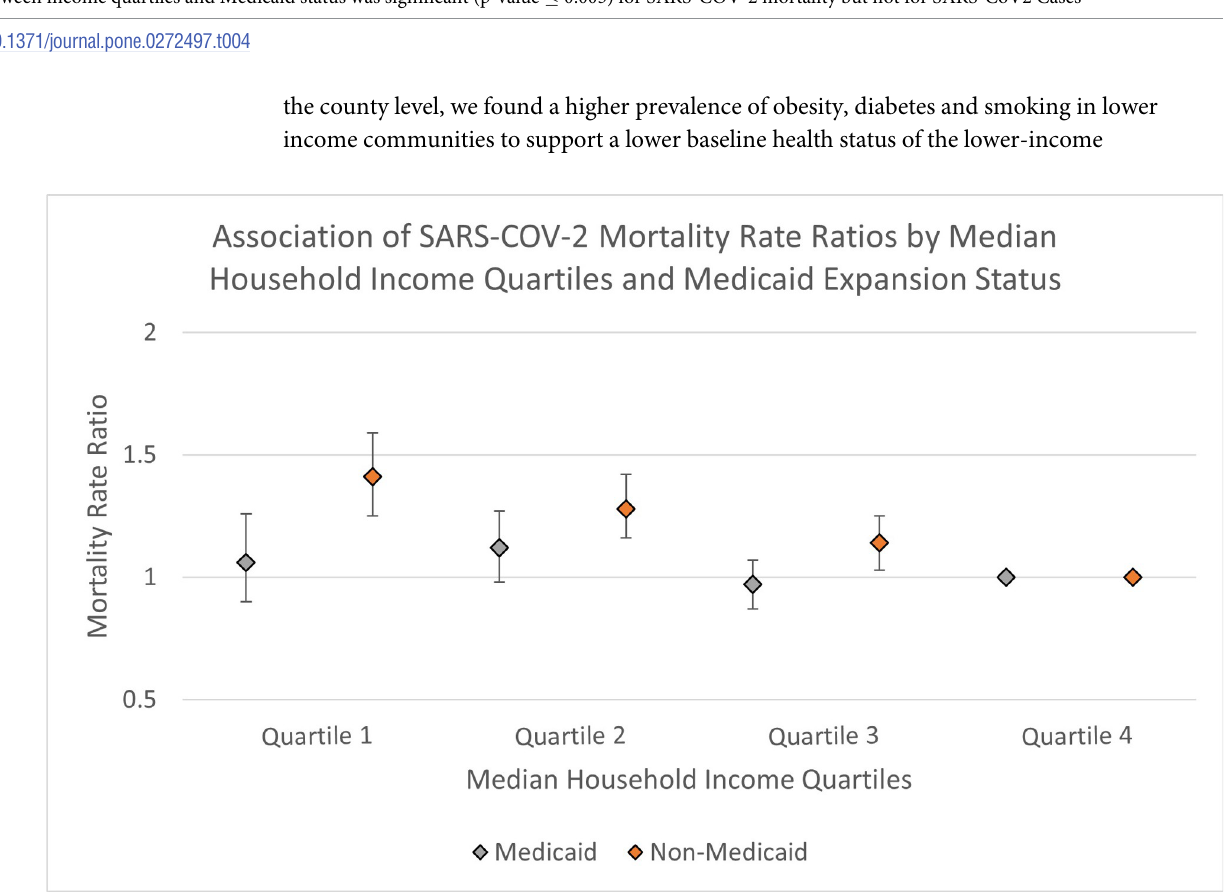
Fig 1. Association of SARS-COV-2 mortality rate ratios (95% confidence intervals) by median household income quartiles, for counties in Medicaid (gray diamond) and non-Medicaid expansion states (orange diamond), referent = Quartile 4. In fully adjusted analyses, median household income quartiles were associated with COVID-19 mortality only in counties within non-Medicaid-expansion states (orange diamond), but there were no significant differences in COVID-19 mortality risk by income quartiles in counties within Medicaid expansion states (gray